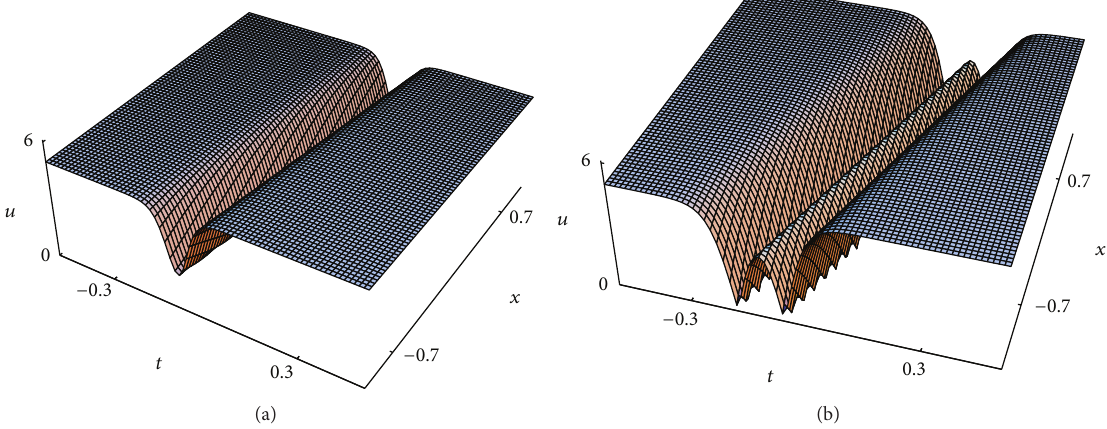
Figure 4: Evolution of the solutions of (25). (a) Dark soliton: parameters are 𝛼 = 1 , 𝛽 = −1 , 𝑎 1 = −5 , 𝑏 0 = 2 , and 𝑘 = −3 . (b) Two-peak dark soliton: parameters are 𝛼 = 1 , 𝛽 = −1 , 𝑎 1 = −5 , 𝑏 0 = 3 , and 𝑘 = 4